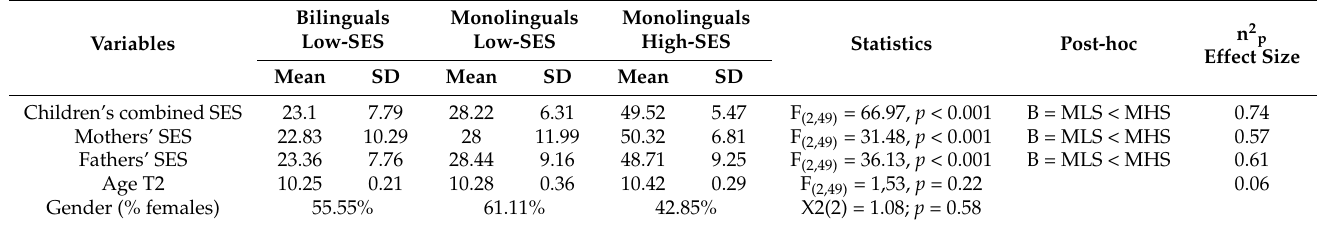
Table 1. Mean and sd scores for demographic variables for the three